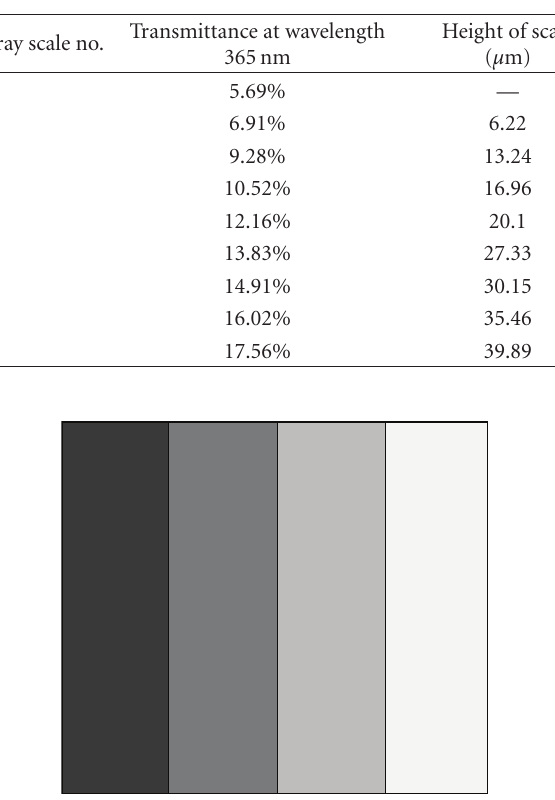
Table 4: The relationship between the light transmittance at wave- length 365 nm and the contour of the surface of the negative of gray scale.